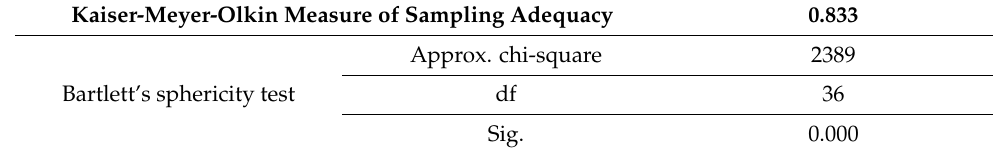
Table 3. KMO and Bartlett’s sphericity tests.